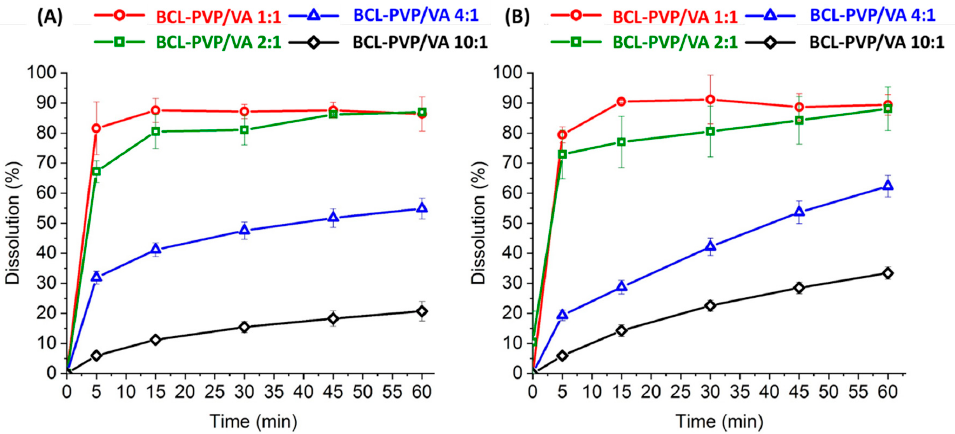
Figure 11. Dissolution profiles of bicalutamide from solid dispersions obtained by either ball milling ( A ) or spray drying ( B ).